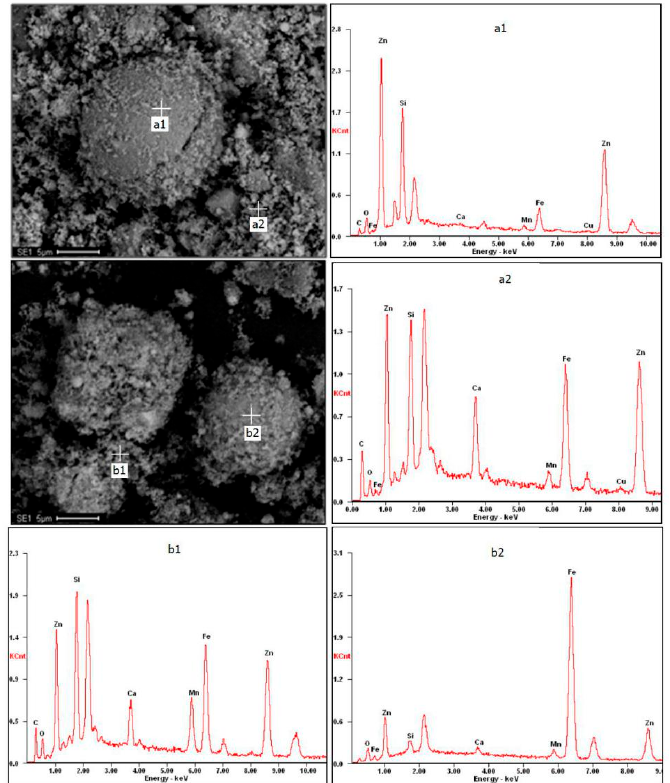
Figure 3. Results of the scanning electron microscopy–energy dispersive spectroscopy